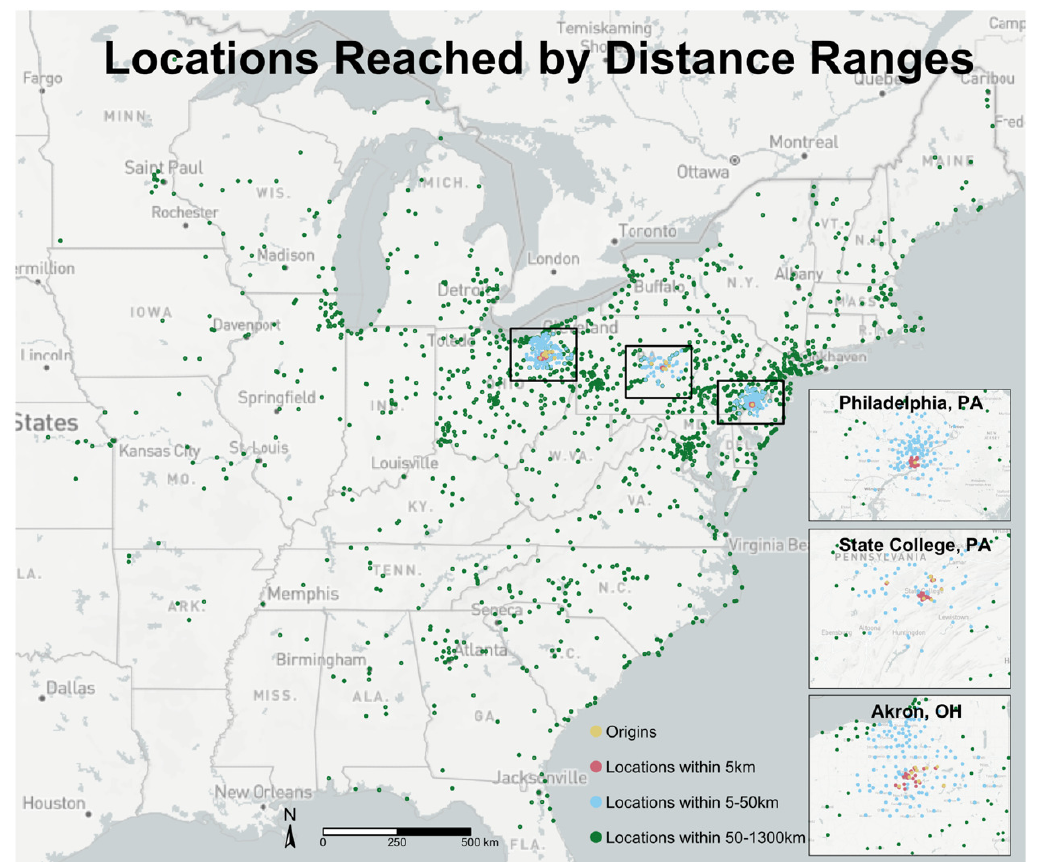
Figure 1. Destinations in different distances range from the respondents’ origin cities. is also the lowest compared with people from other clus‐ ters (Figure 2). Among all cities, Philadelphia has the high‐ est percentage of people identified as hyperlocal (41%), which reflects Boessen et al. (2018)’s observation that people living in denser neighborhoods are more likely to have a restricted geographic reach, as well as prior find‐ ings that deprived populations have smaller social net‐ works (see Small,